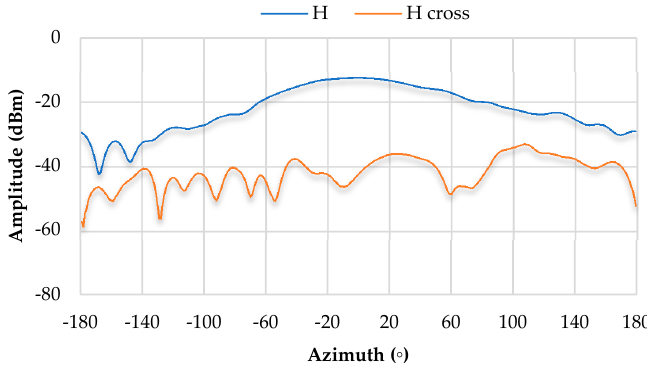
Figure 21. Representation of the radiation diagram for 0° in the H plane.